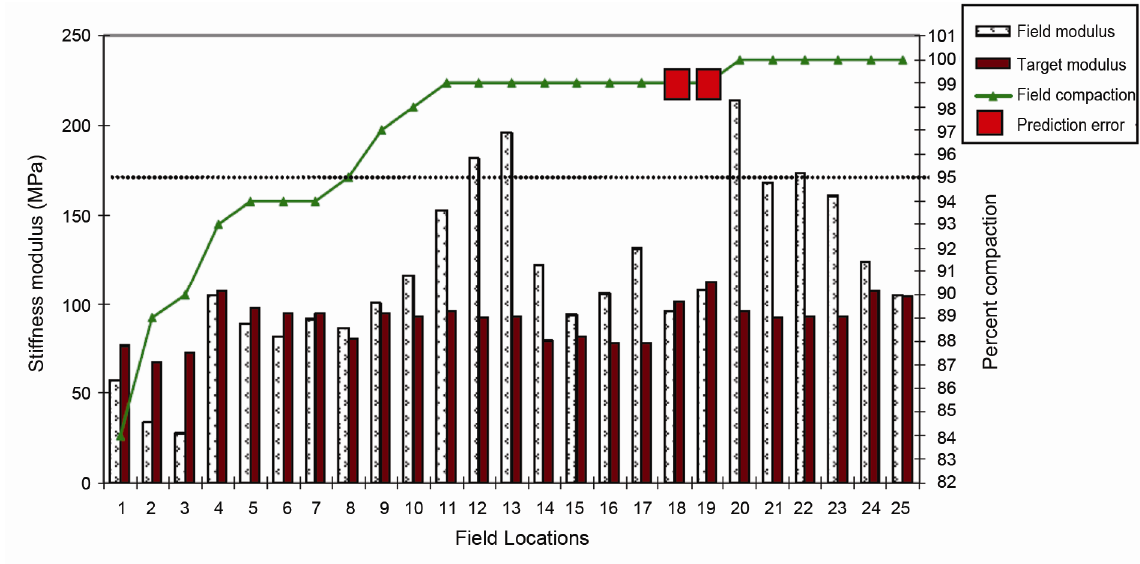
Fig. 13. Relationship between PFWD modulus and FWD